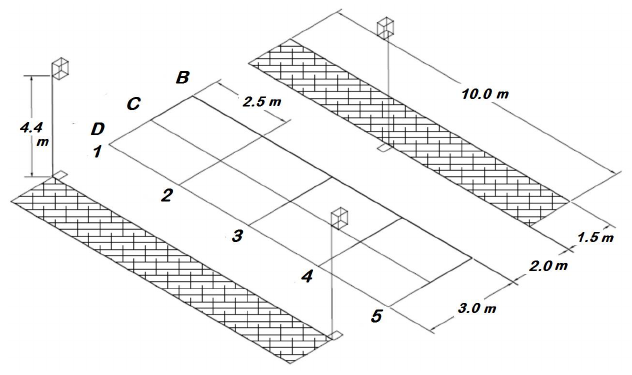
Figure 2. Testing 3D rendering sector in a road with quincunx staggered luminaires.